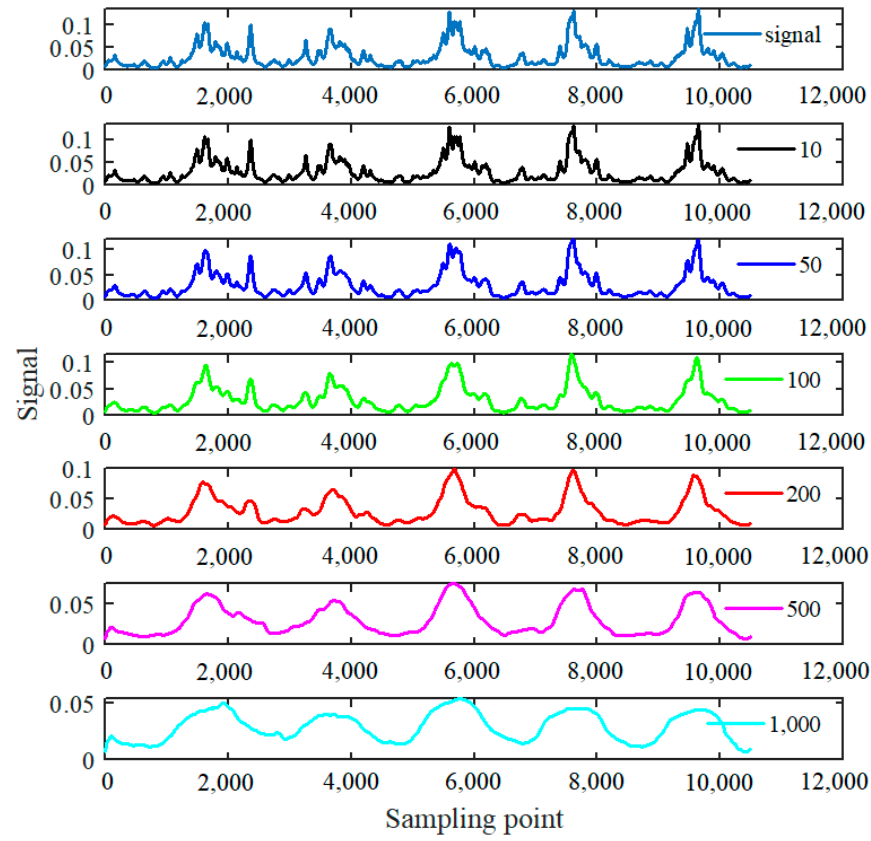
Figure 10. Signals processed by different moving average spans.